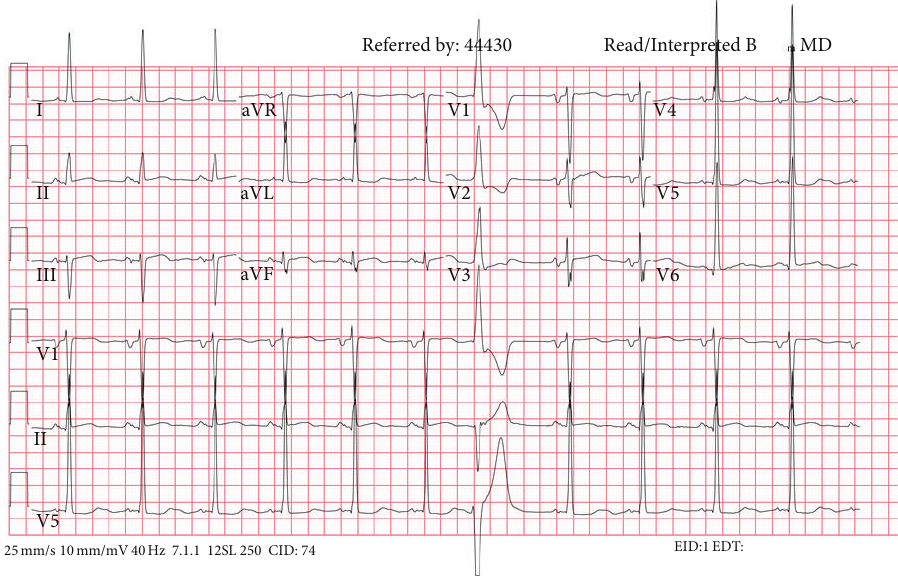
Figure 1: 12-lead electrocardiogram.